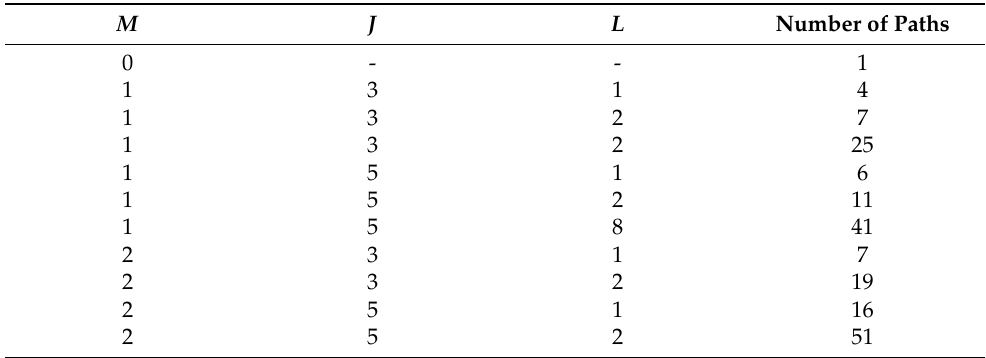
Table 1. System parameters for